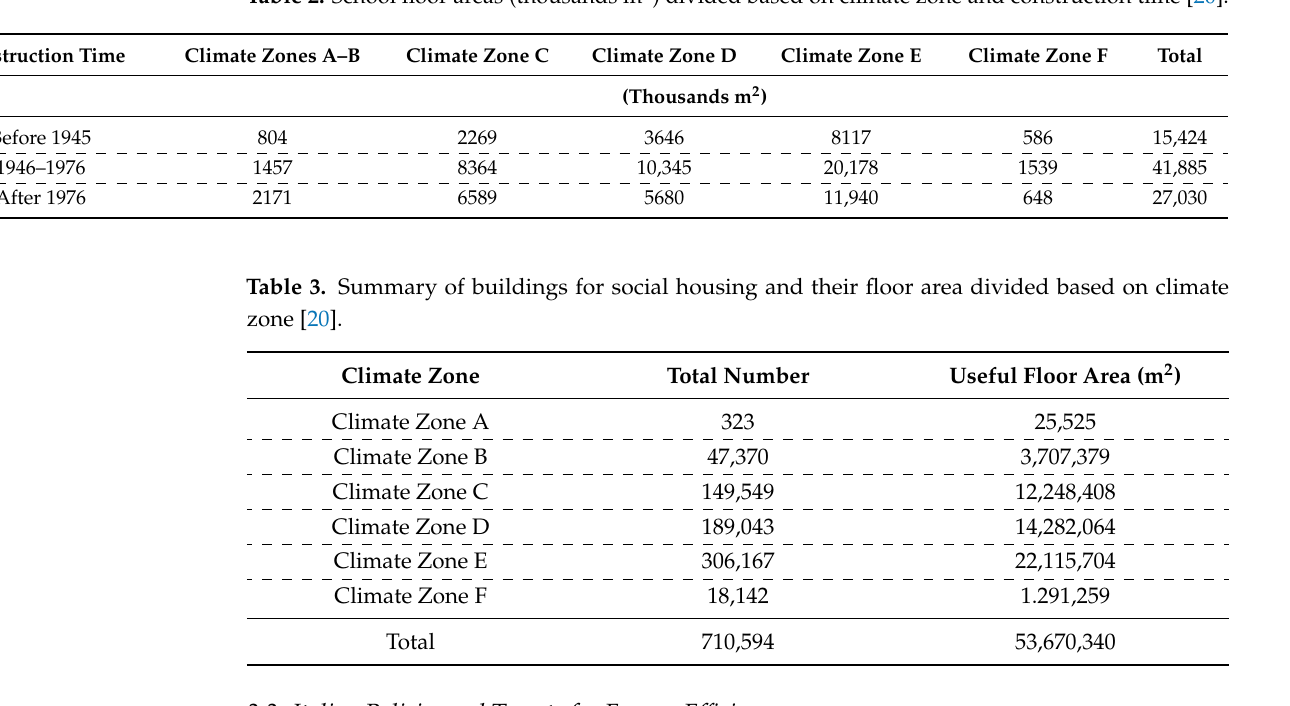
Table 2. School floor areas (thousands m 2 ) divided based on climate zone and construction time [20].